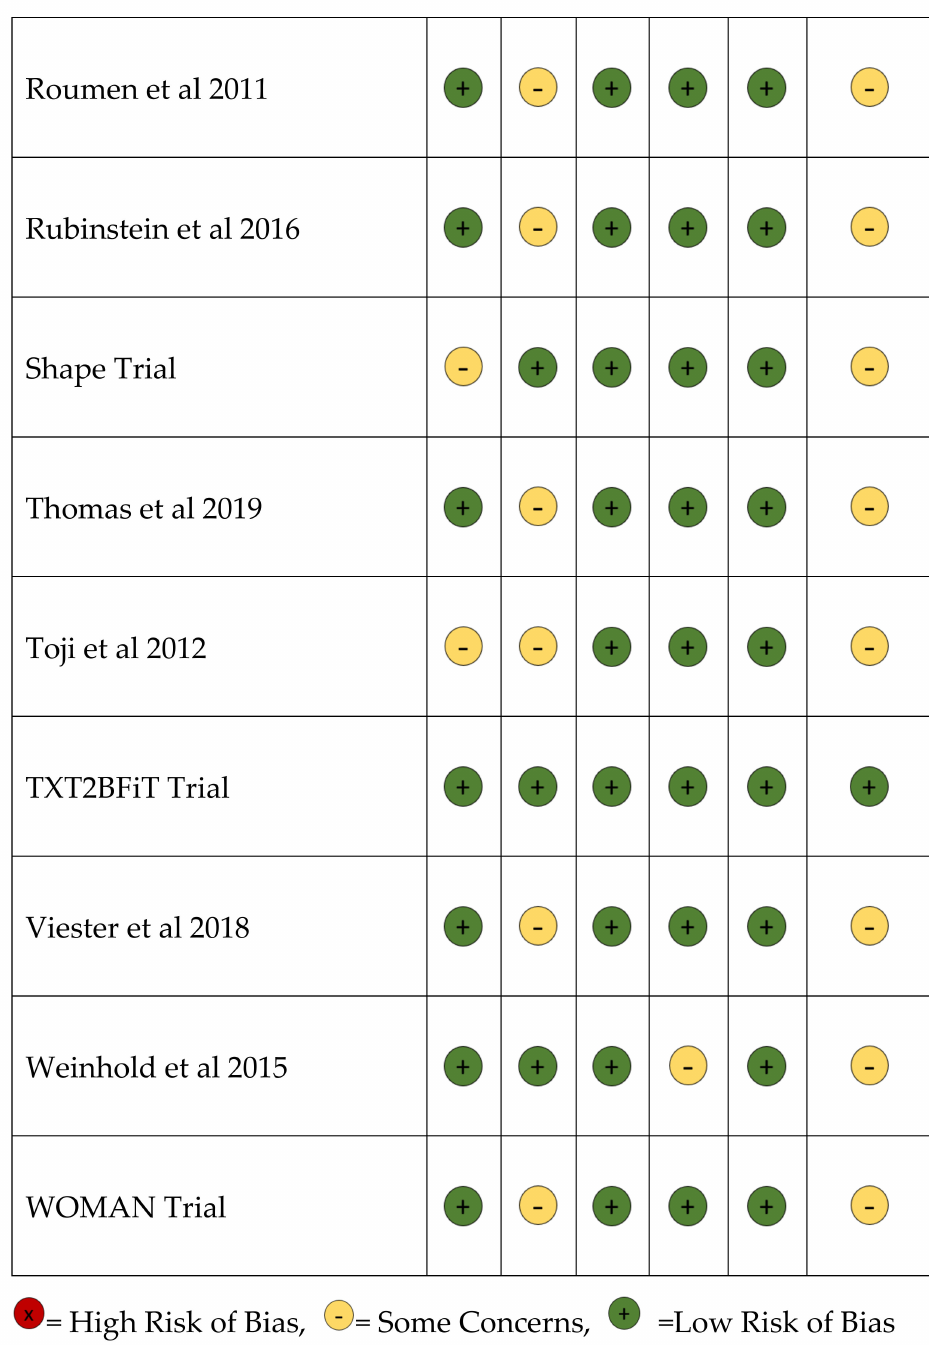
Figure 2. Risk of bias in the systematic review examining effect of nutrition and physical activity interventions provided by nutrition and exercise practitioners for the general population